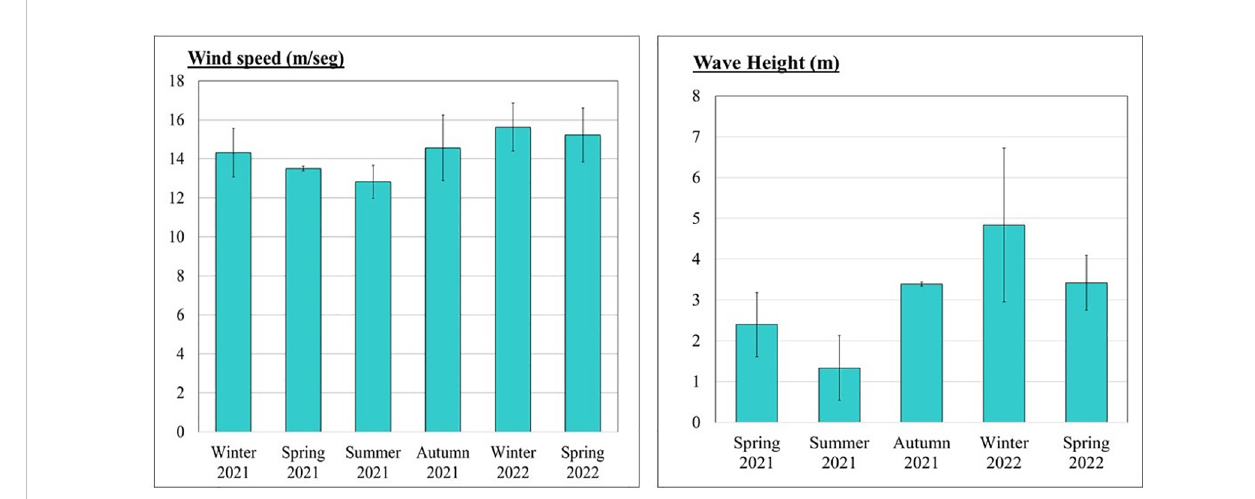
FIGURE 5 Wind speed (left) and wave height (right) data in the study area during the project